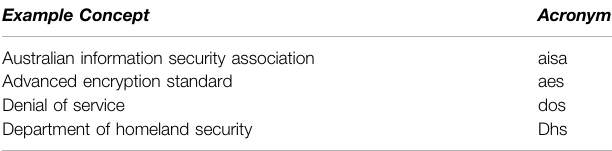
TABLE 2 | Examples of acronyms generated for cybersecurity-related